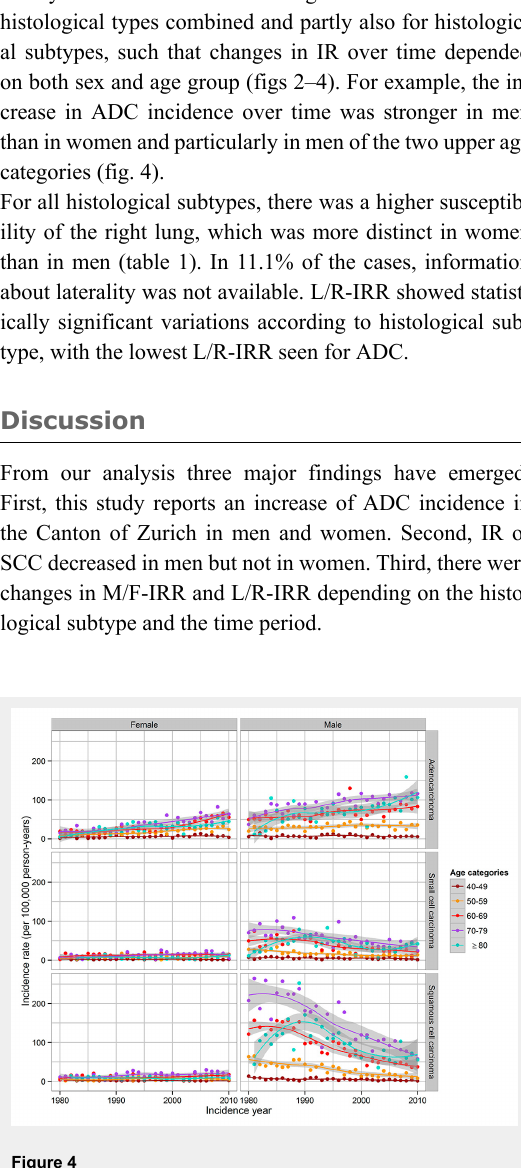
Trends in lung cancer incidence by sex, major histological type and age categories in the Canton of Zurich, Switzerland, 1980–2010. NOS = not otherwise specified.